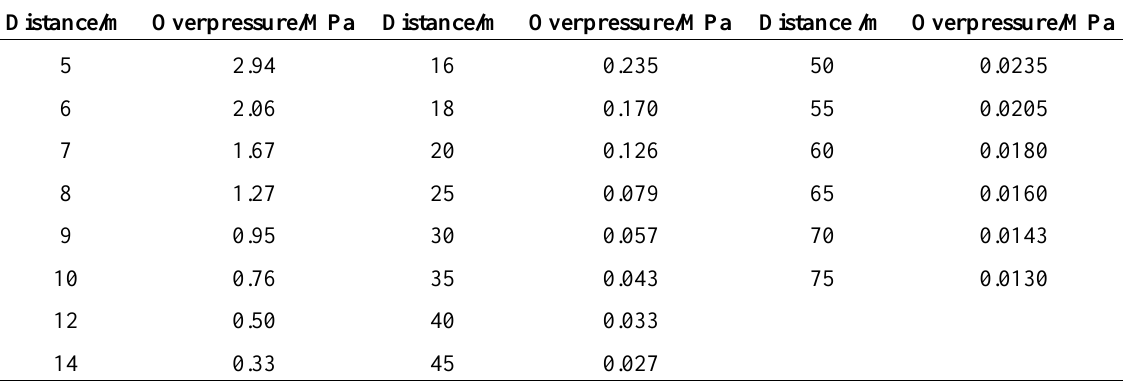
Table 3. Relationship between the shock wave overpressure and distance from a 1000 kg TNT explosion.